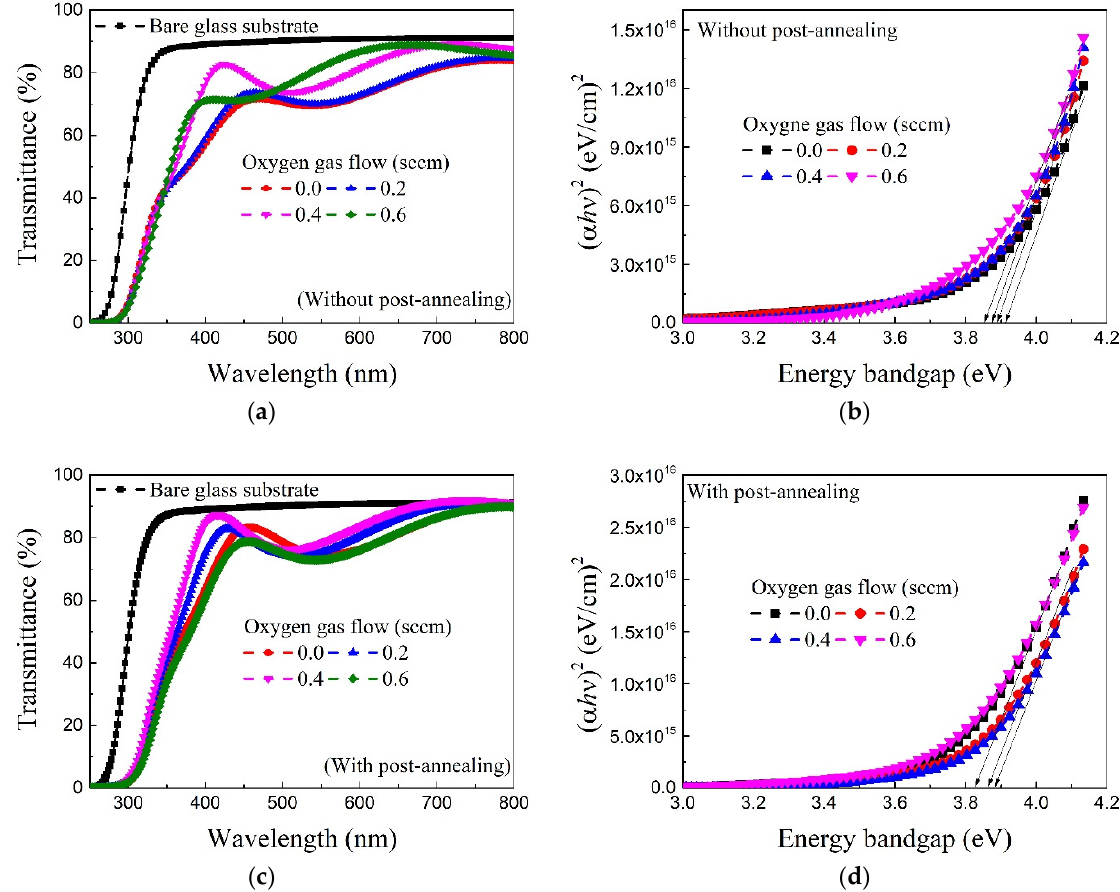
Figure 3. Optical transmittance and energy bandgap of ITO films as a function of wavelength at various rates of oxygen-gas flow ( a ) and ( b ) without post-annealing and ( c ) and ( d ) with post-an- nealing at 480